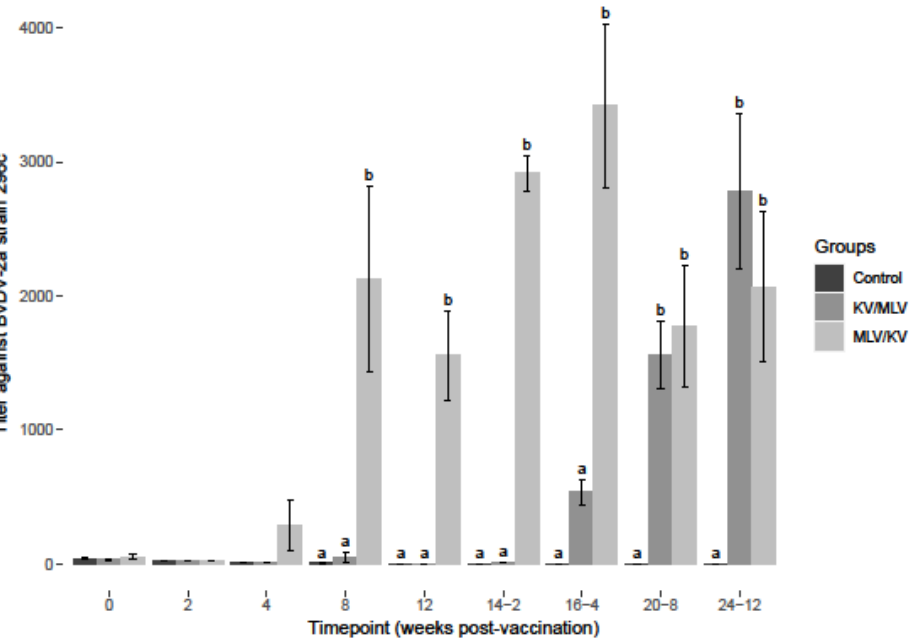
Figure 1. Average virus neutralization titers from sera collected at respective timepoints over the course of the study against BVDV-2a (296c) refence strain. Values at each timepoint, not connected by the same letter are significantly different ( p < 0.05).